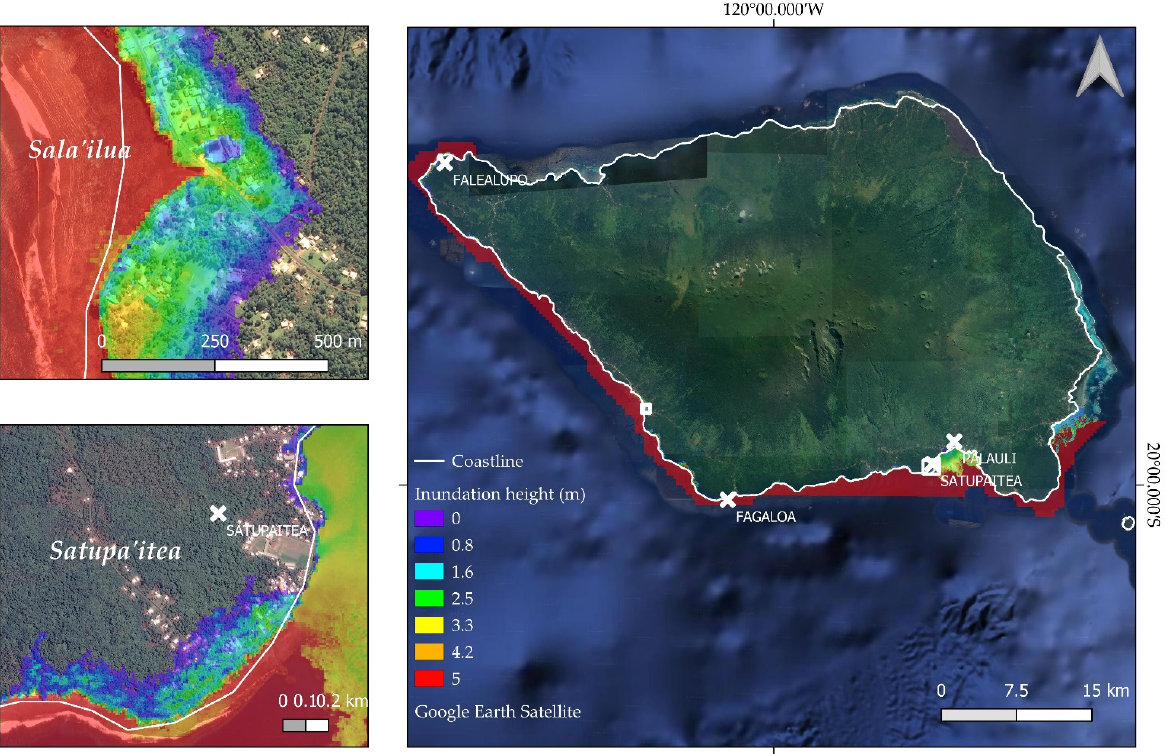
Figure 6. Inundation on Savai’i in close-ups (10 m horizontal resolution). The map shows the 10 m resolution run-up on Savai’i ( a ) and close-up of inundation in Satuiatua ( b ), and in Palauli and Satupa’itea ( c ).